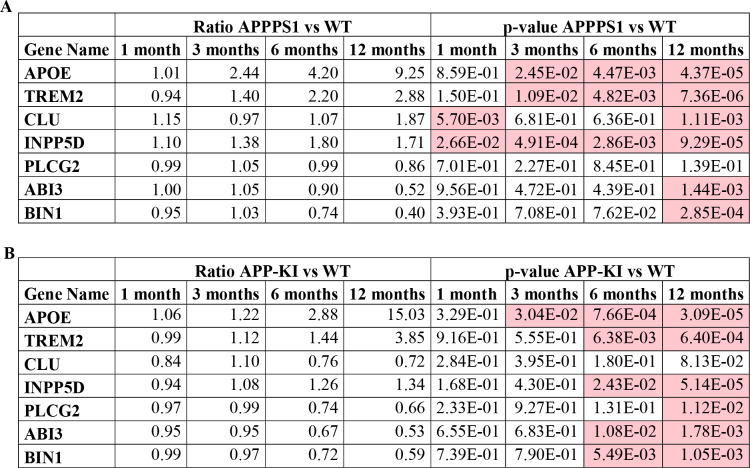
Relative quantification of proteins from seven AD risk genes in APPPS1.LFQ ratios and p-values of AD risk genes found regulated in APPPS1 (A) and APP-KI (B) microglia are presented. p-values less than 0.05 are indicated in red.